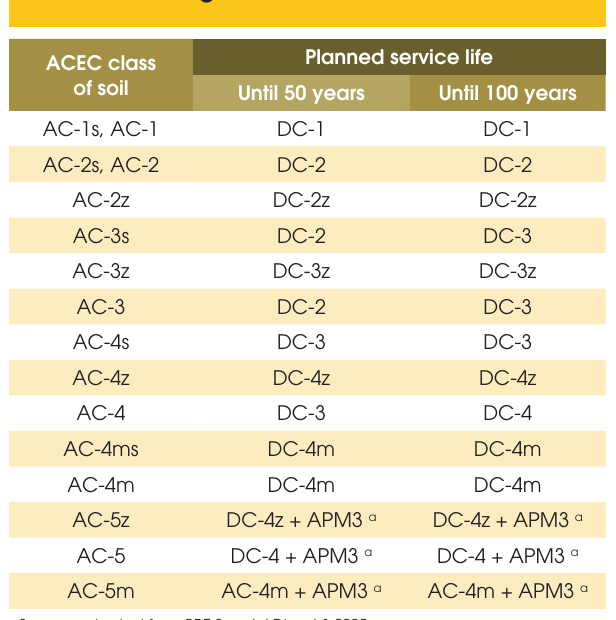
Table 9 – DC class and APM number for concrete elements in zones with hydraulic gradient less than or equal to 5: concrete for